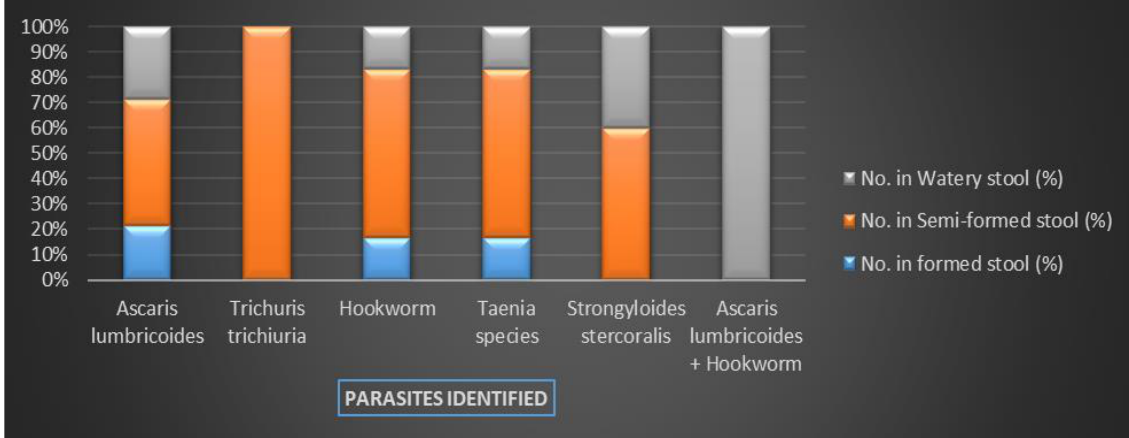
Figure 1. Occurrence of intestinal helminths based on stool consistency of HIV patients attending Faith Alive Foundation,